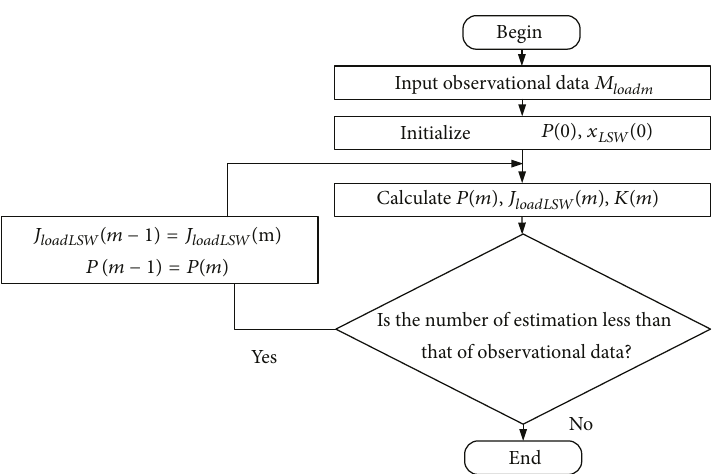
Figure 4: The flow block diagram of the recursive least squares estimation